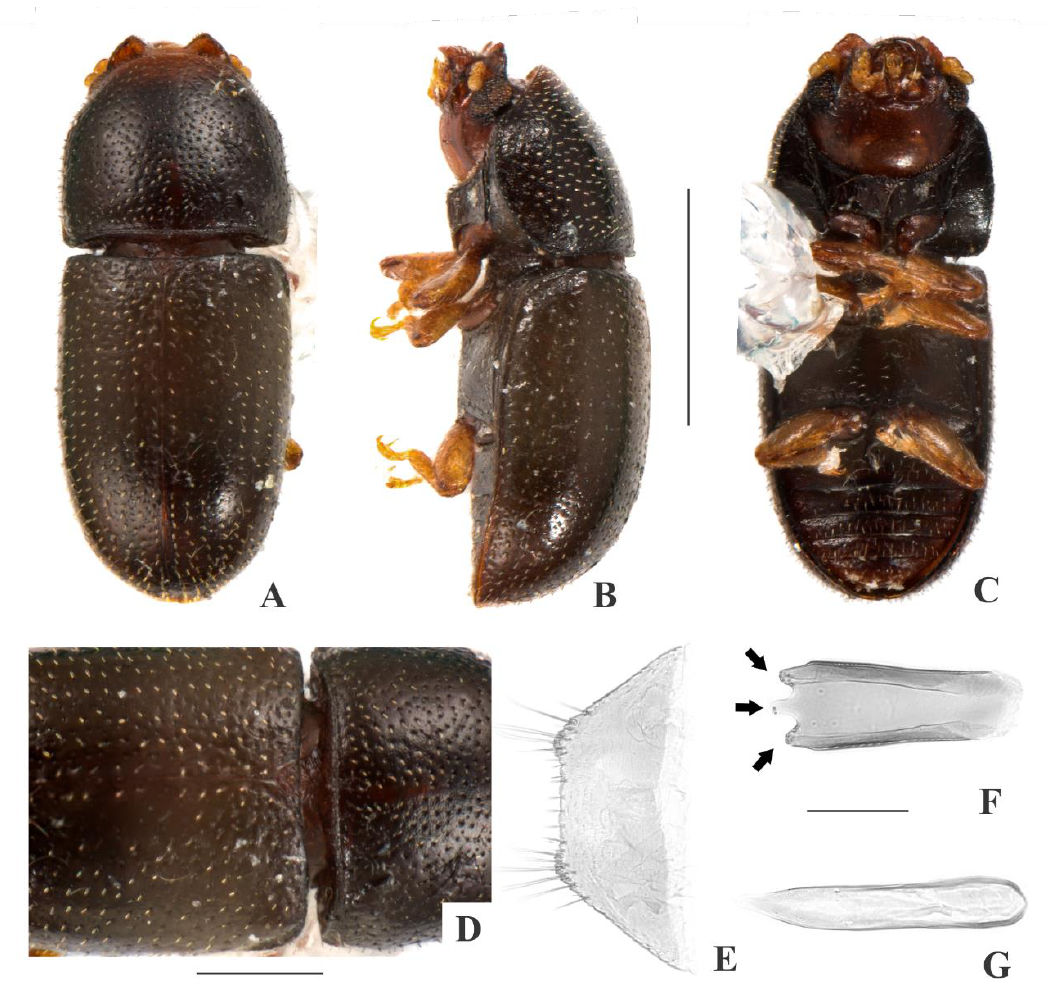
Figure 11. Cis umlalaziensis sp. n. , male holotype ( A – D ), aedeagus of paratype from type locality ( E – G ): ( A ) Dorsal view. ( B ) Lateral view. ( C ) Ventral view. ( D ) Scutellar shield and part of the pronotum and elytra. ( E ) Sternite VIII. ( F ) Tegmen, note rounded lobes at apex (black arrows). ( G ) Penis. Scale bars: 0.5 mm ( A – C ), 0.2 mm ( D ), 0.05 mm ( E – G ). Cis sp. K in Neser